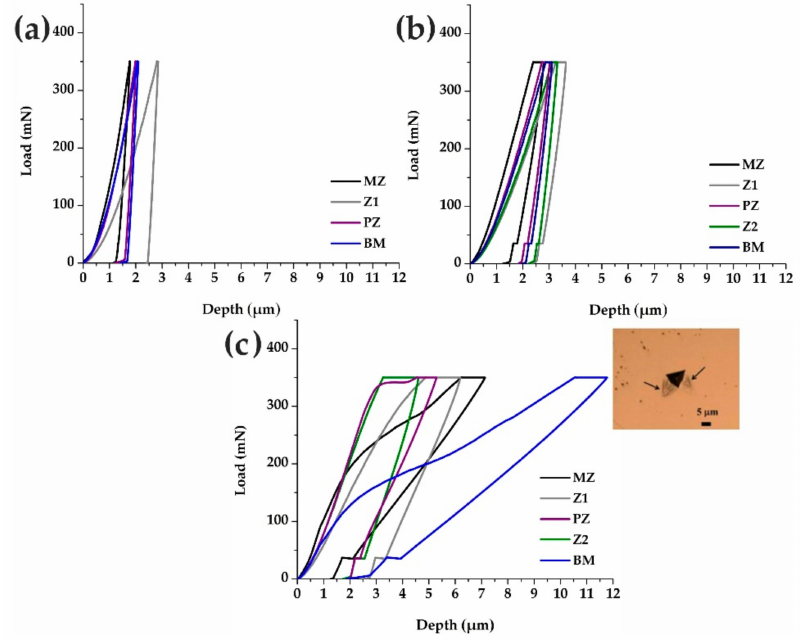
Figure 17. Load-depth curves on the di ff erent zones of wedge-samples: ( a ) Sol-Wasp; ( b ) Ni-Age-Wasp; and ( c ) Ni-Sol-Wasp.